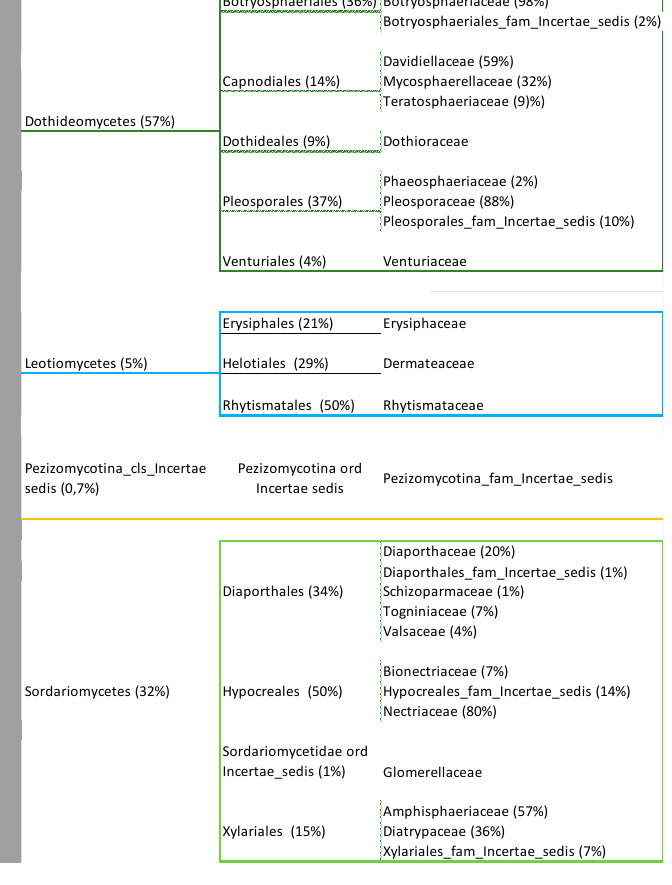
Figure 3. Relative abundance of different taxonomic groups within the Ascomycota of OTUs classified as plant pathogens.